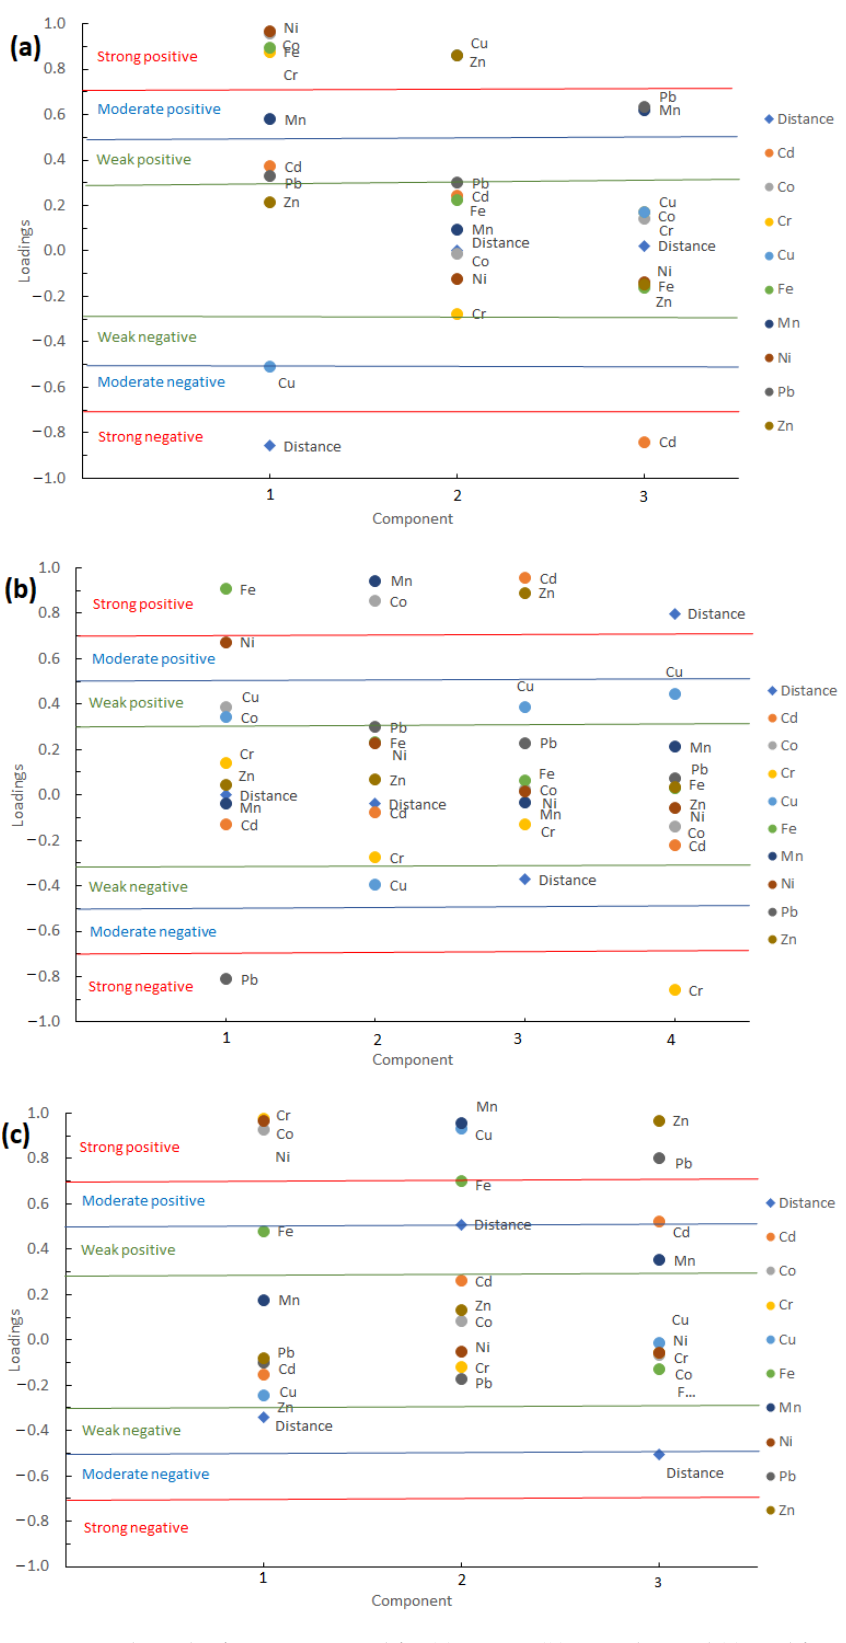
Figure 3. Loading plot for PCs extracted for ( a ) Eretria, ( b ) Domokos and ( c ) steel